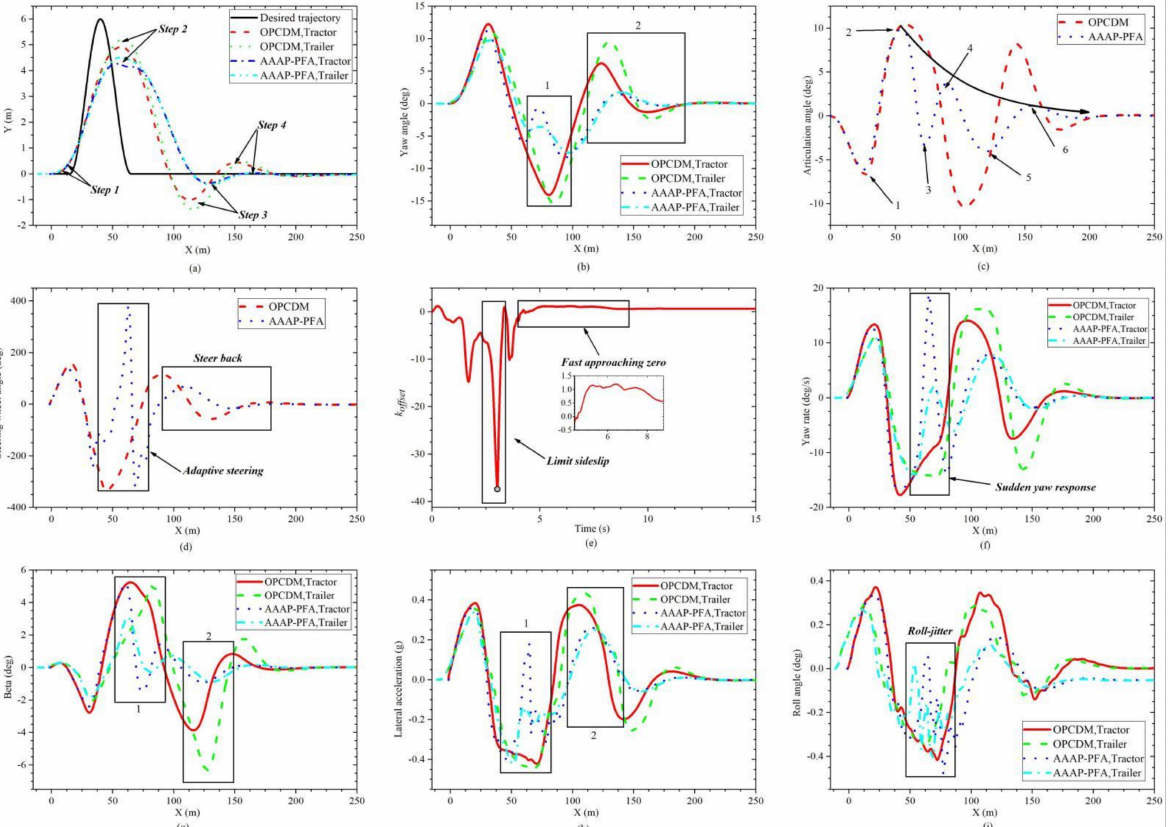
Figure 11. Comparison results of OPCDM and AAAP-PFA under low road adhesion conditions. ( a ) Trajectory. ( b ) Yaw angle. ( c ) Articulation angle. ( d ) Steering angle. ( e ) Koffset. ( f ) Yaw rate. ( g ) Beta. ( h ) Lateral acceleration. ( i ) Roll